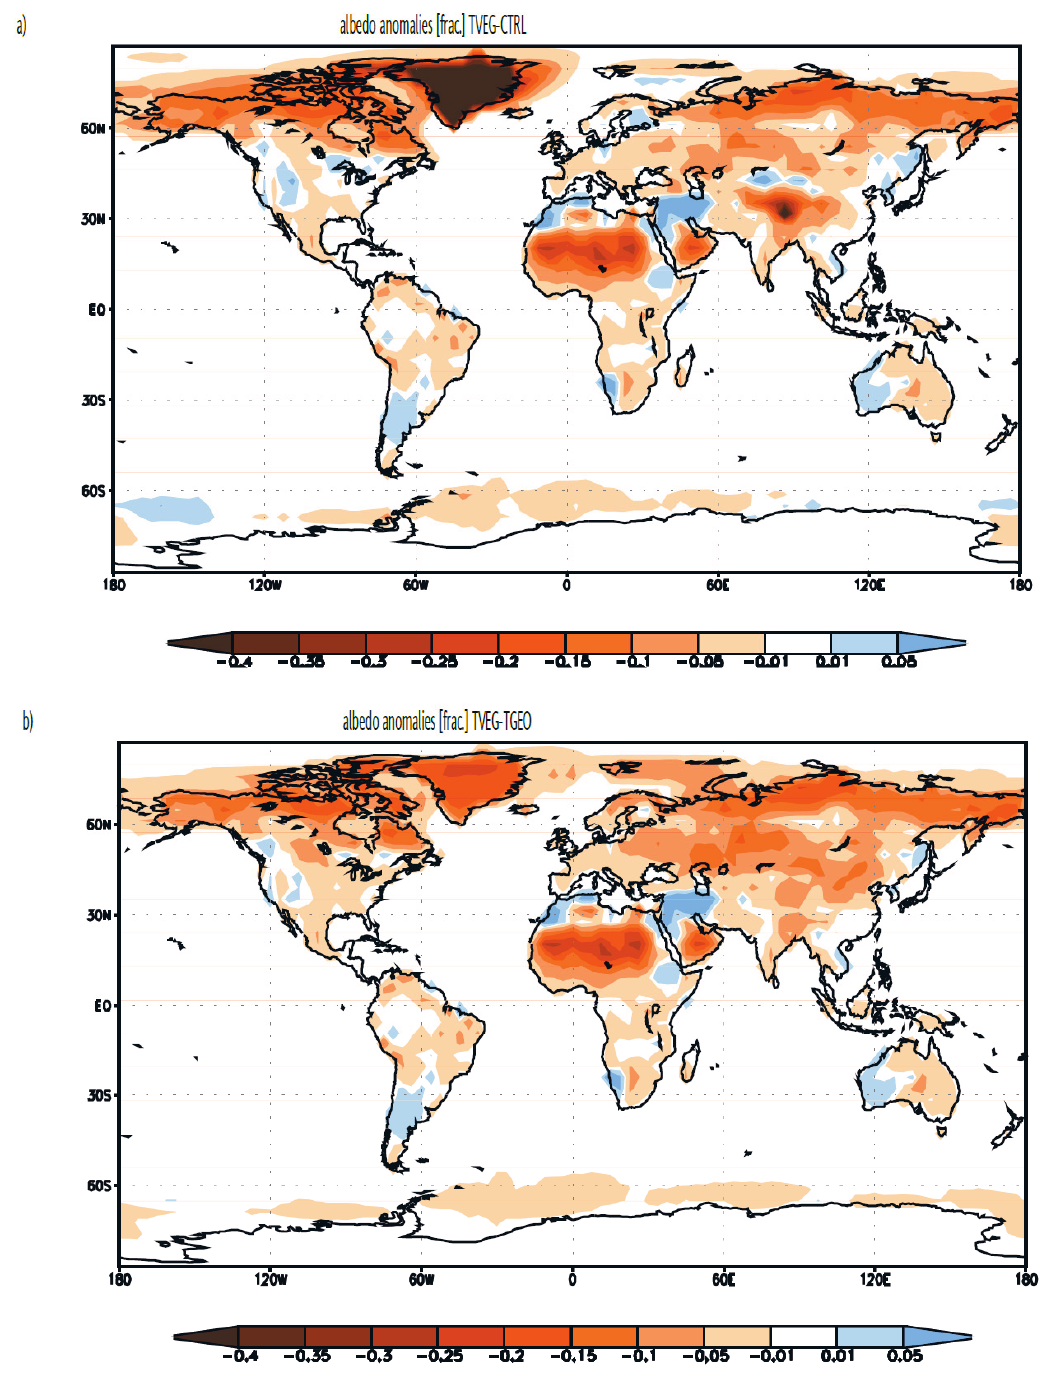
Figure 3. Changes in the mean annual albedo (frac.) for ( a ) TVEG minus CTRL; and for ( b ) TVEG minus